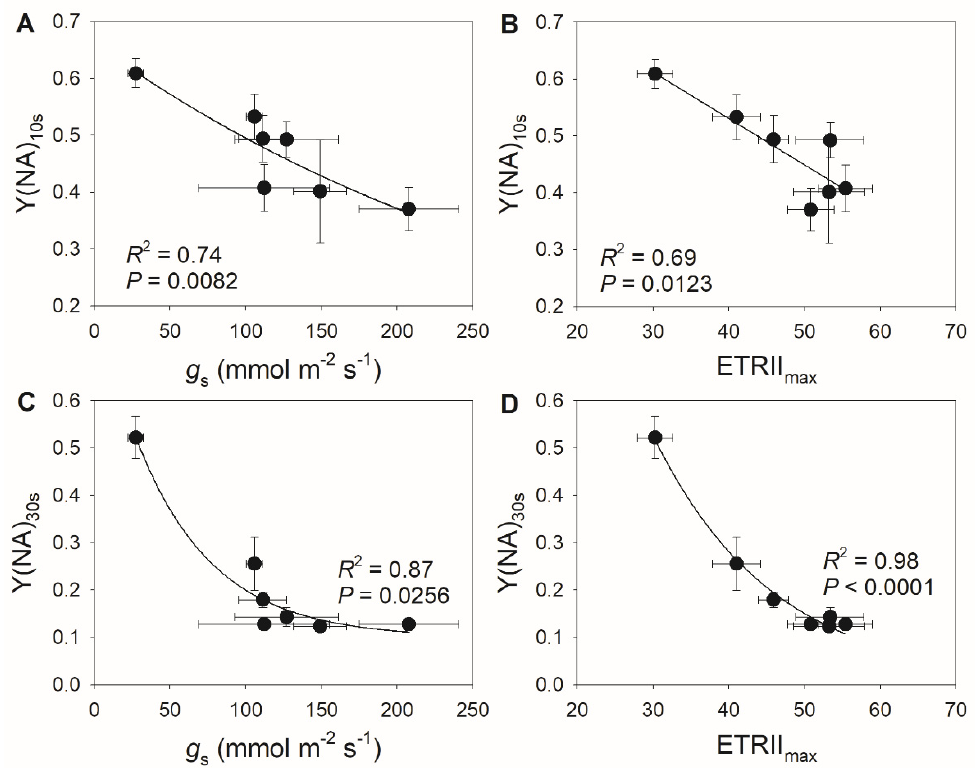
Figure 5. Relationships between ( A ) stomatal conductance ( g s ) and Y(NA) after transition from low to high light for 10 s (Y(NA) 10 s ), between ( B ) maximum electron transport rate through PSII (ETRII max ) and Y(NA) 10 s , between ( C ) stomatal conductance ( g s ) and Y(NA) after transition from low to high light for 30 s (Y(NA) 30 s ), and between ( D ) ETRII max and Y(NA) 30 s in M. alba leaves. All data are from Figure 4.